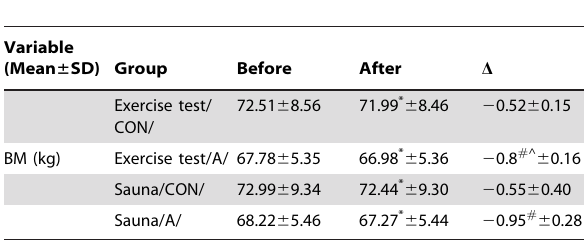
Table 2. Changes in body mass (BM) after performing the exercise test and after sauna bathing in untrained men (CON) and athletes